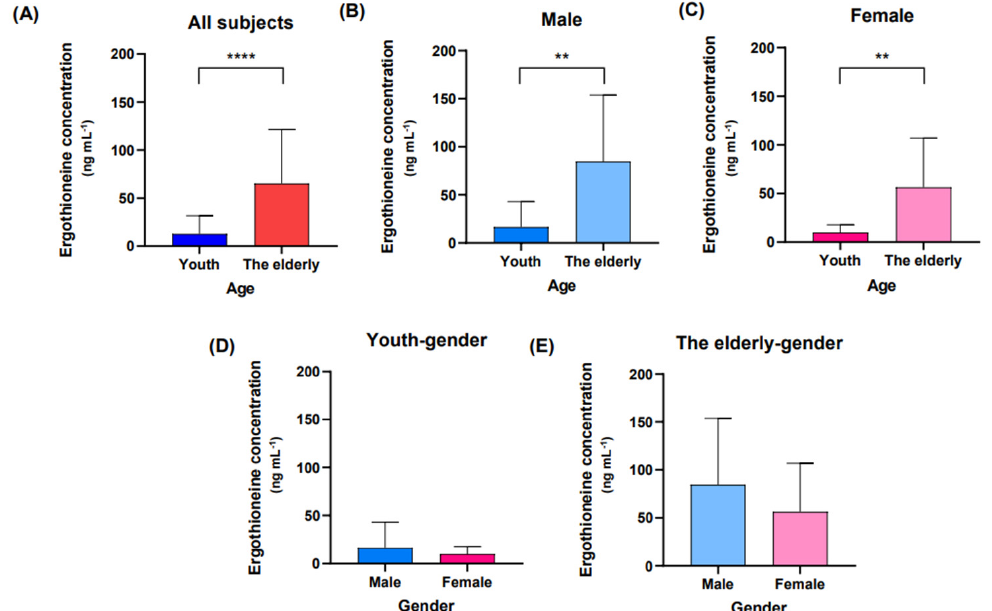
Figure 1. Ergothioneine concentrations on day 0. Day 0 bloodstains were created by dripping fresh blood onto filter paper, and metabolite extraction was performed immediately after bloodstain production. ( A ) Comparison of ergothioneine concentrations between the youth and elderly groups on day 0. The youth group is represented by the blue bars and the elderly group is represented by the red bars. ( B , C ) Comparison of ergothioneine concentrations between the youth group and the elderly group in sex-separated groups. ( D , E ) Comparison of ergothioneine concentrations between males and females in the same age group. The male group is shown in light blue, the female group is shown in pink. An unpaired t -test or Mann–Whitney test was performed for comparison between groups, and the values in the graph represent Mean ± SD. ** p < 0.01 and **** p < 0.0001.